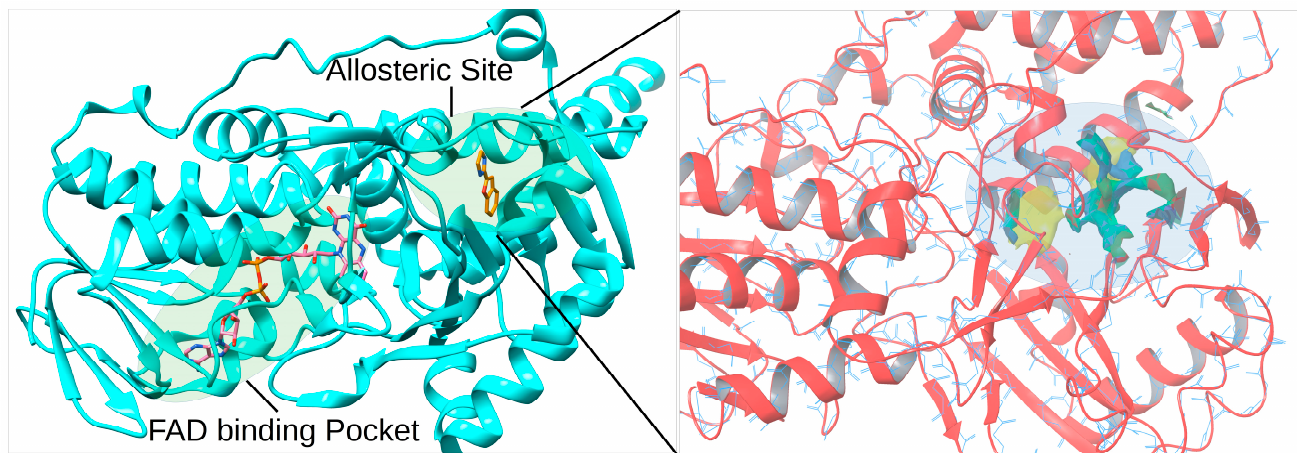
Figure 2. Indicates the full overlapped image of the acceptor (red), donor (blue), hydrophilic (green), and hydrophobic (yellow) region, respectively, in the binding site identified with the SiteMap module.